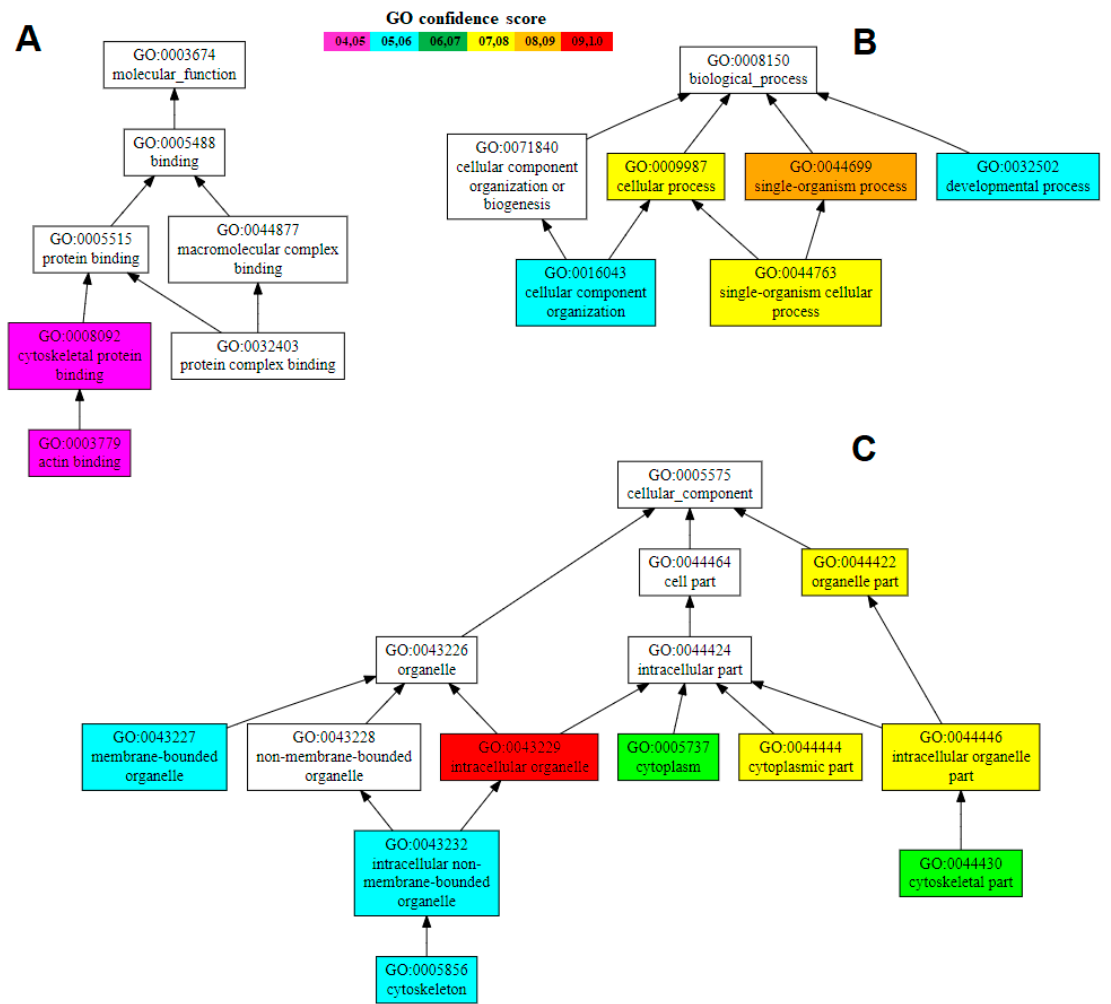
Figure 5. Gene ontology based on the Hdh-TPM protein sequence: ( A ) Molecular function indicating actin-binding cytoskeletal protein. ( B ) Biological processes, including single-organism cellular process through cellular component organization and development. ( C ) Cellular component indicating intracellular organelle, especially the cytoskeleton.